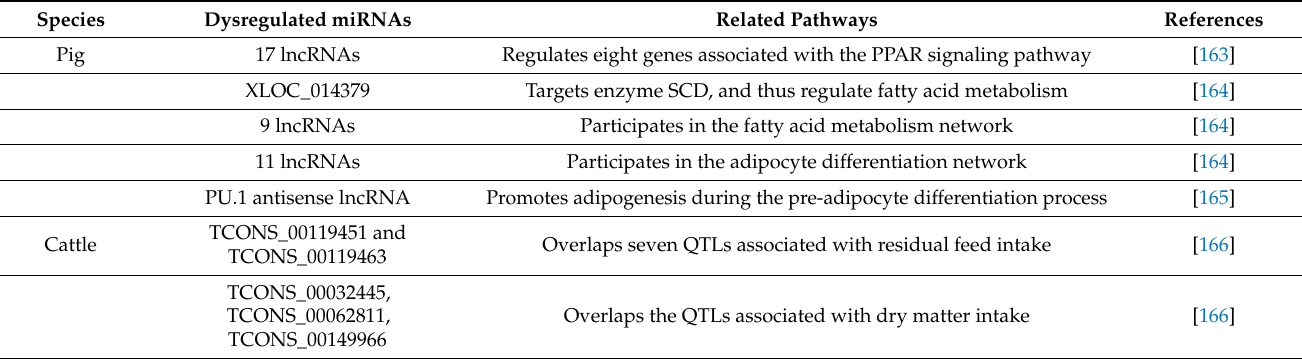
Table 3. Long non-coding RNAs in feed